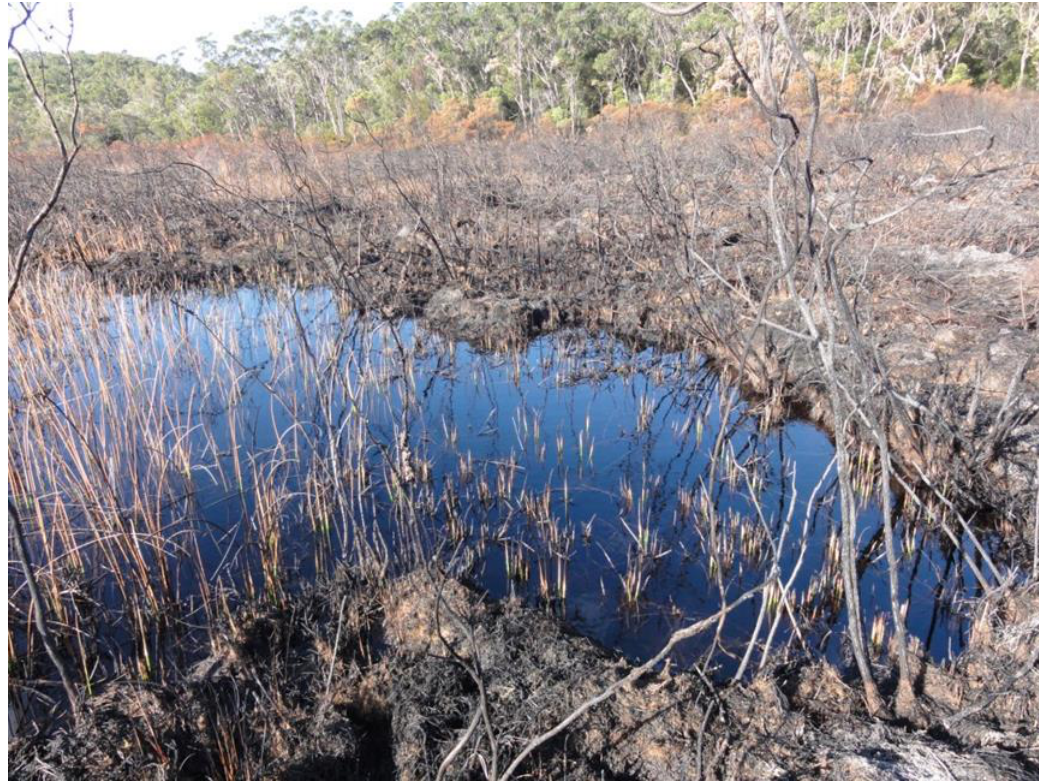
Figure 4. A non-linear pool near the mouth of Wanggoolba Creek (Fraser Island) which was burnt on 01 June 2011. The bases of the two Leptospermum liversigei shrubs (bottom right) are covered in negatively geotropic Empodisma minus